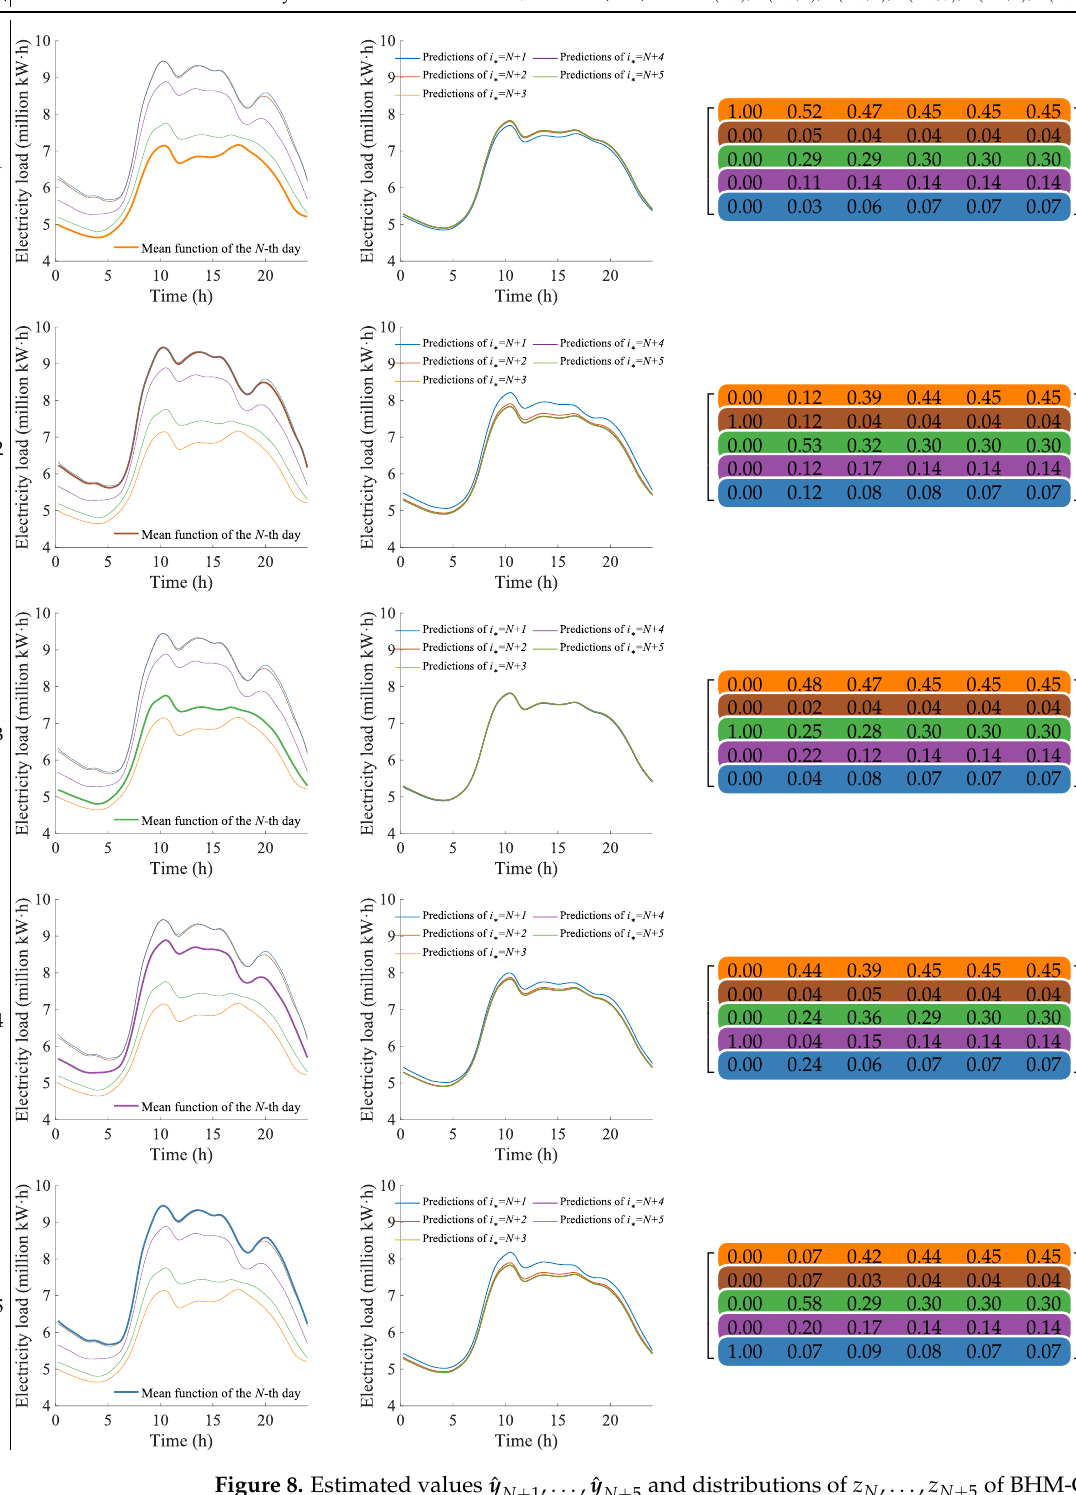
, . . . , ˆ y and distributions of z N , . . . , z N + 5 of BHM-GPFR under N + 1 N + 5